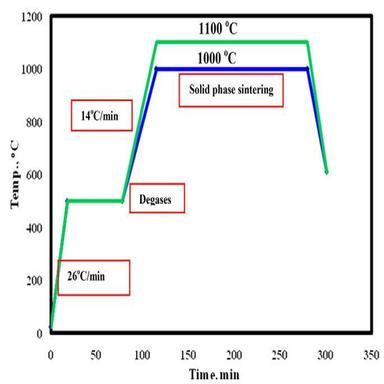
Sintering cycle of Cu/WC-TiC-Co/GNs nano-composites.